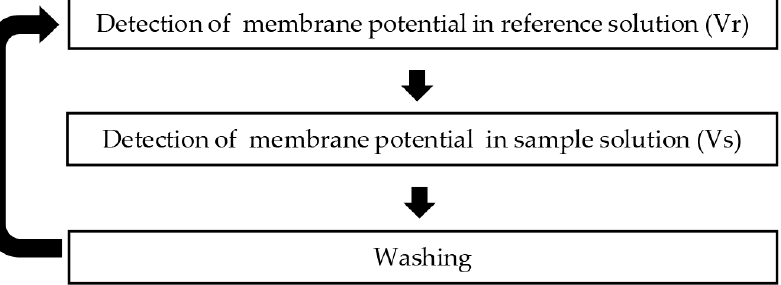
Figure 3. Measurement procedure for the taste sensor.